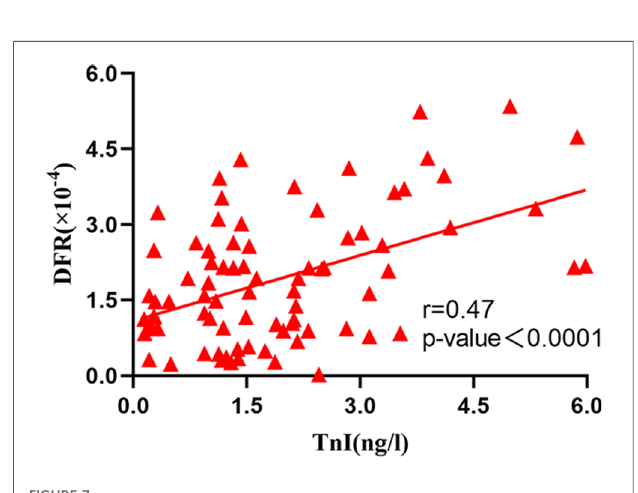
FIGURE 7 Correlation between serum TnI and DFR after operation.